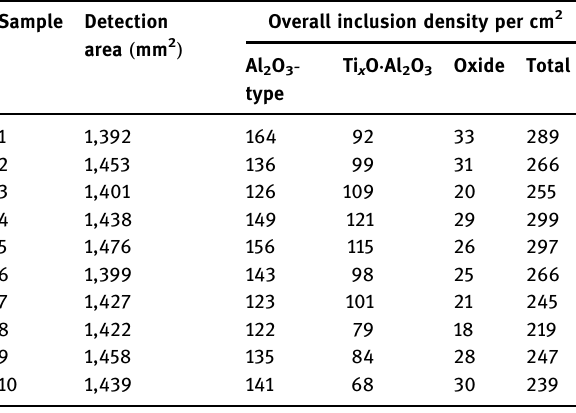
Table 5: Overall inclusion quantity in molten steel samples modi - fi ed by the original modi fi er ( samples 1 – 5 ) and the new modi fi er ( samples 6 – 10 )